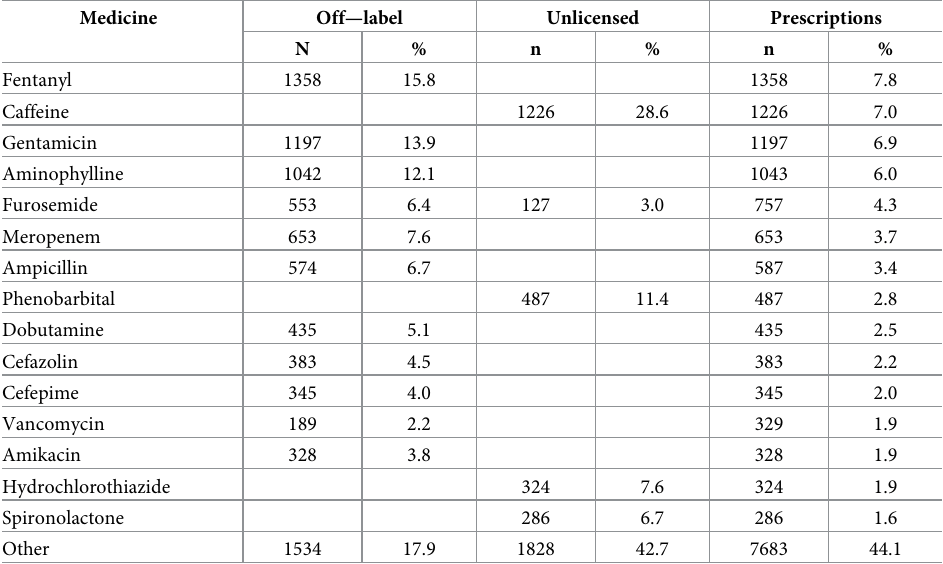
Table 5. Frequency distribution of medicines prescribed as off-label and unlicensed according to FDA criteria.